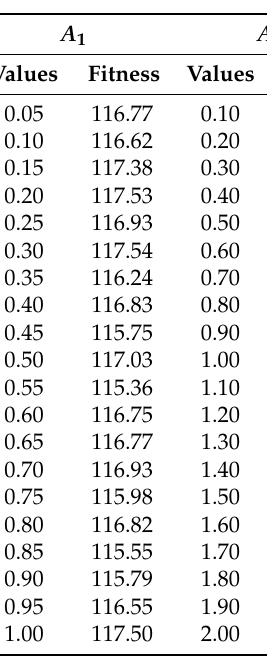
Table 16. Minimization results for different values of ADSCFGWO’s parameters (2).